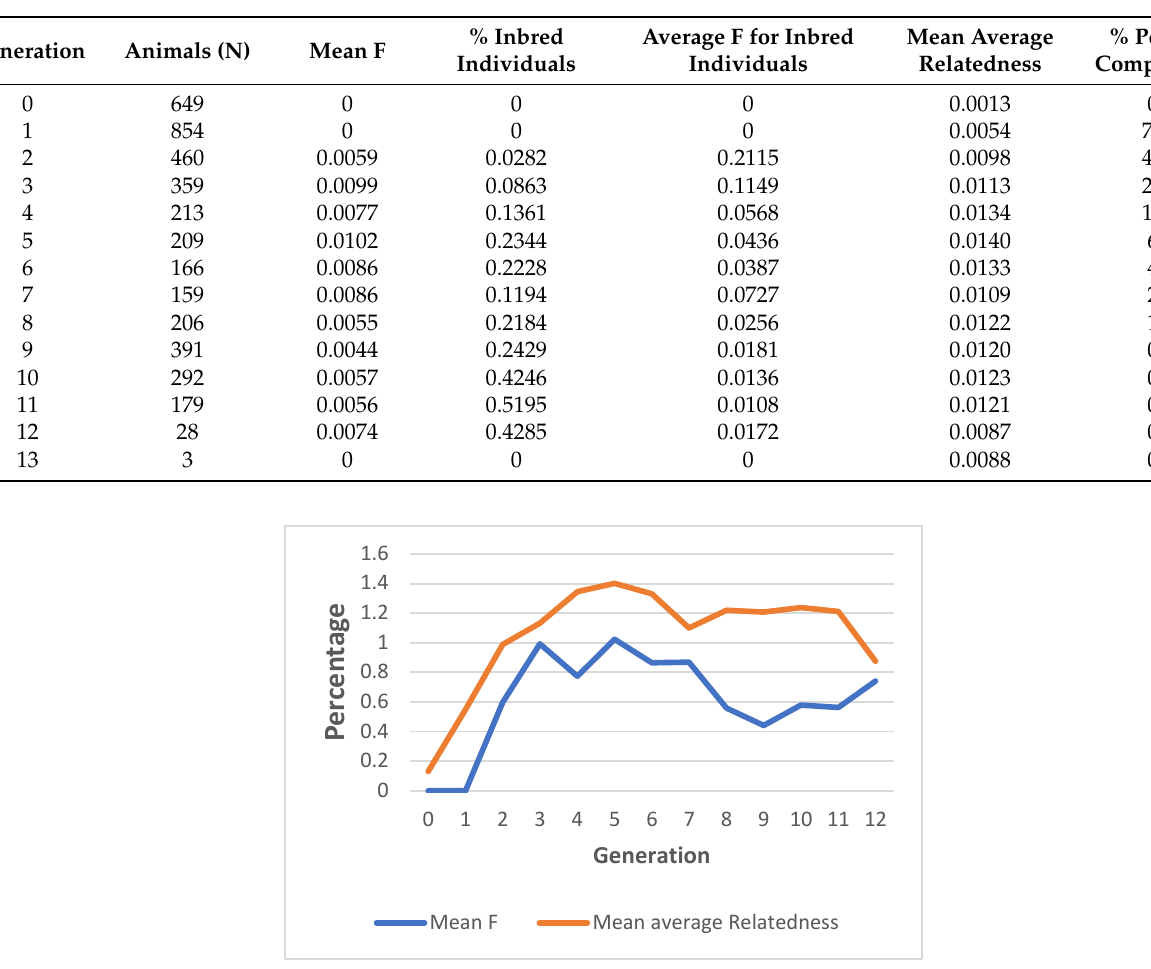
Table 6. Mean inbreeding (F), average relatedness, and per cent pedigree completeness.